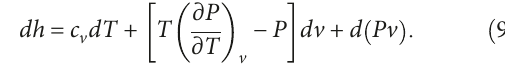
Table 2: Maximum densities (1000K and 35MPa) and critical densities (Data from